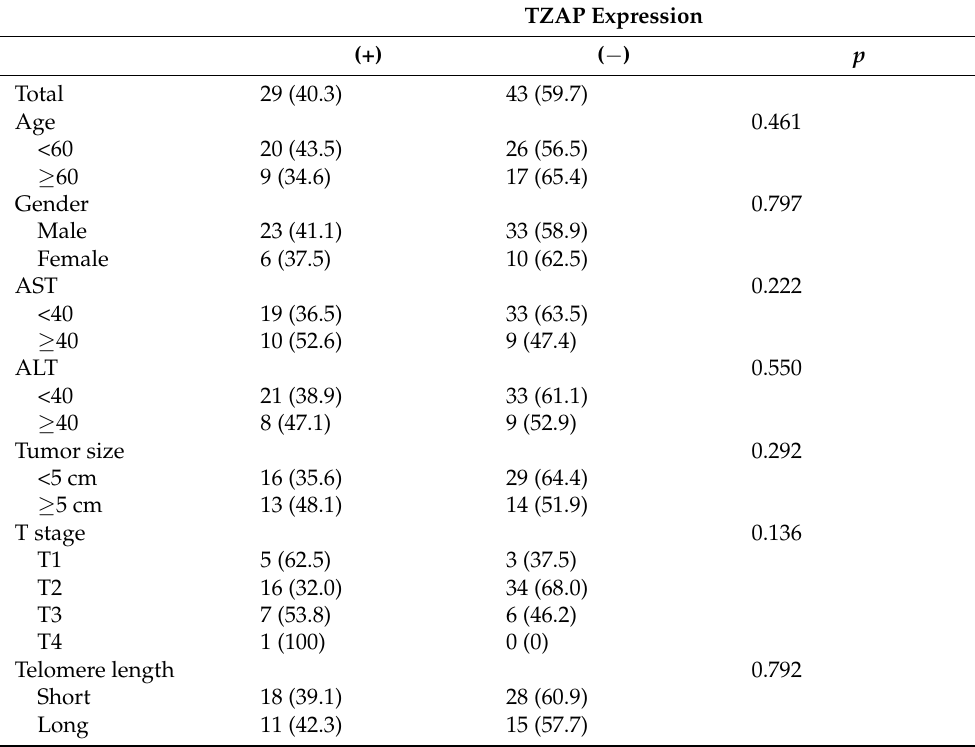
Table 1. Clinicopathological significance of TZAP expressions in